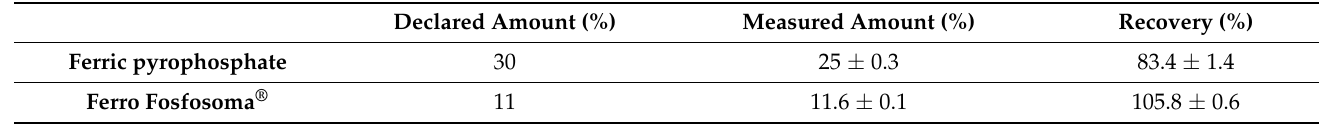
Table 1. Fe amount/dose in tested formulations, expressed as mg/g. The percentage of recovery was calculated as the ratio between measured and nominal Fe values. Results are expressed as mean ± standard deviation.